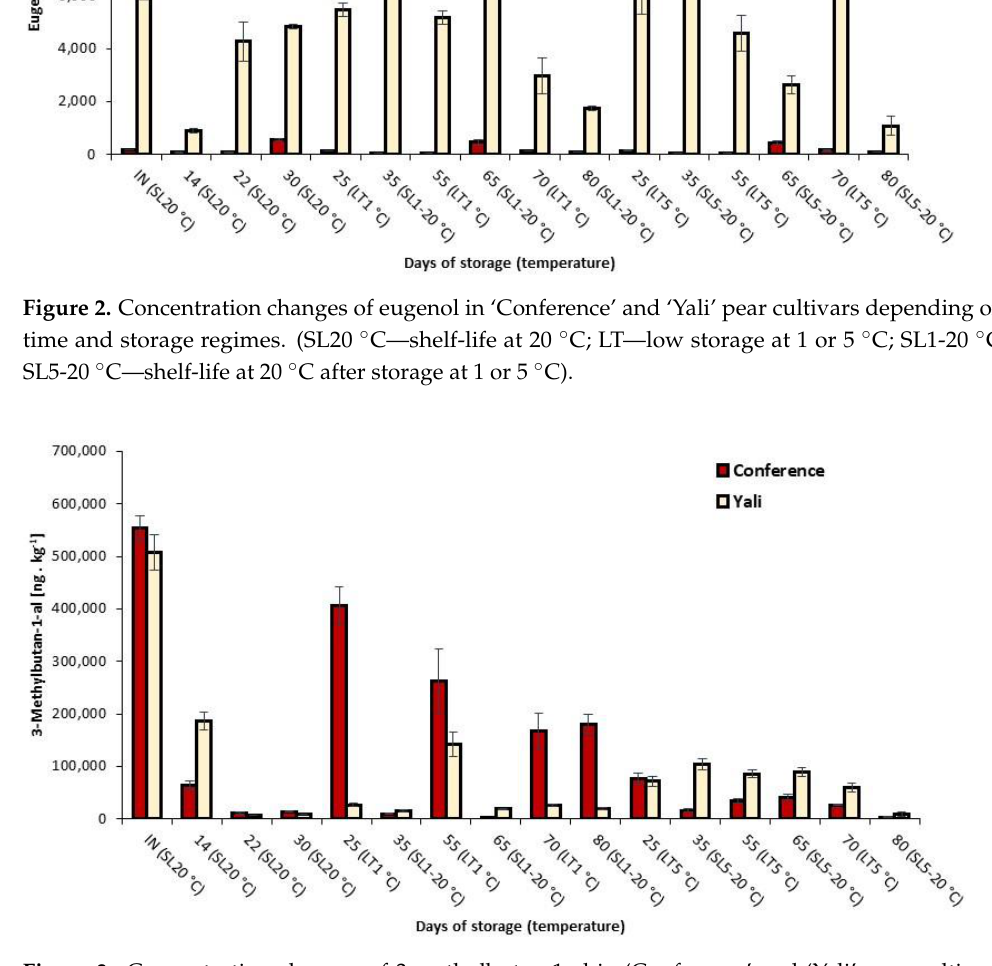
Figure 2. Concentration changes of eugenol in ‘Conference’ and ‘Yali’ pear cultivars depending on time and storage regimes. (SL20 °C — shelf-life at 20 °C; LT — low storage at 1 or 5 °C; SL1-20 °C, SL5- 20 °C — shelf-life at 20 °C after storage at 1 or 5 °C).